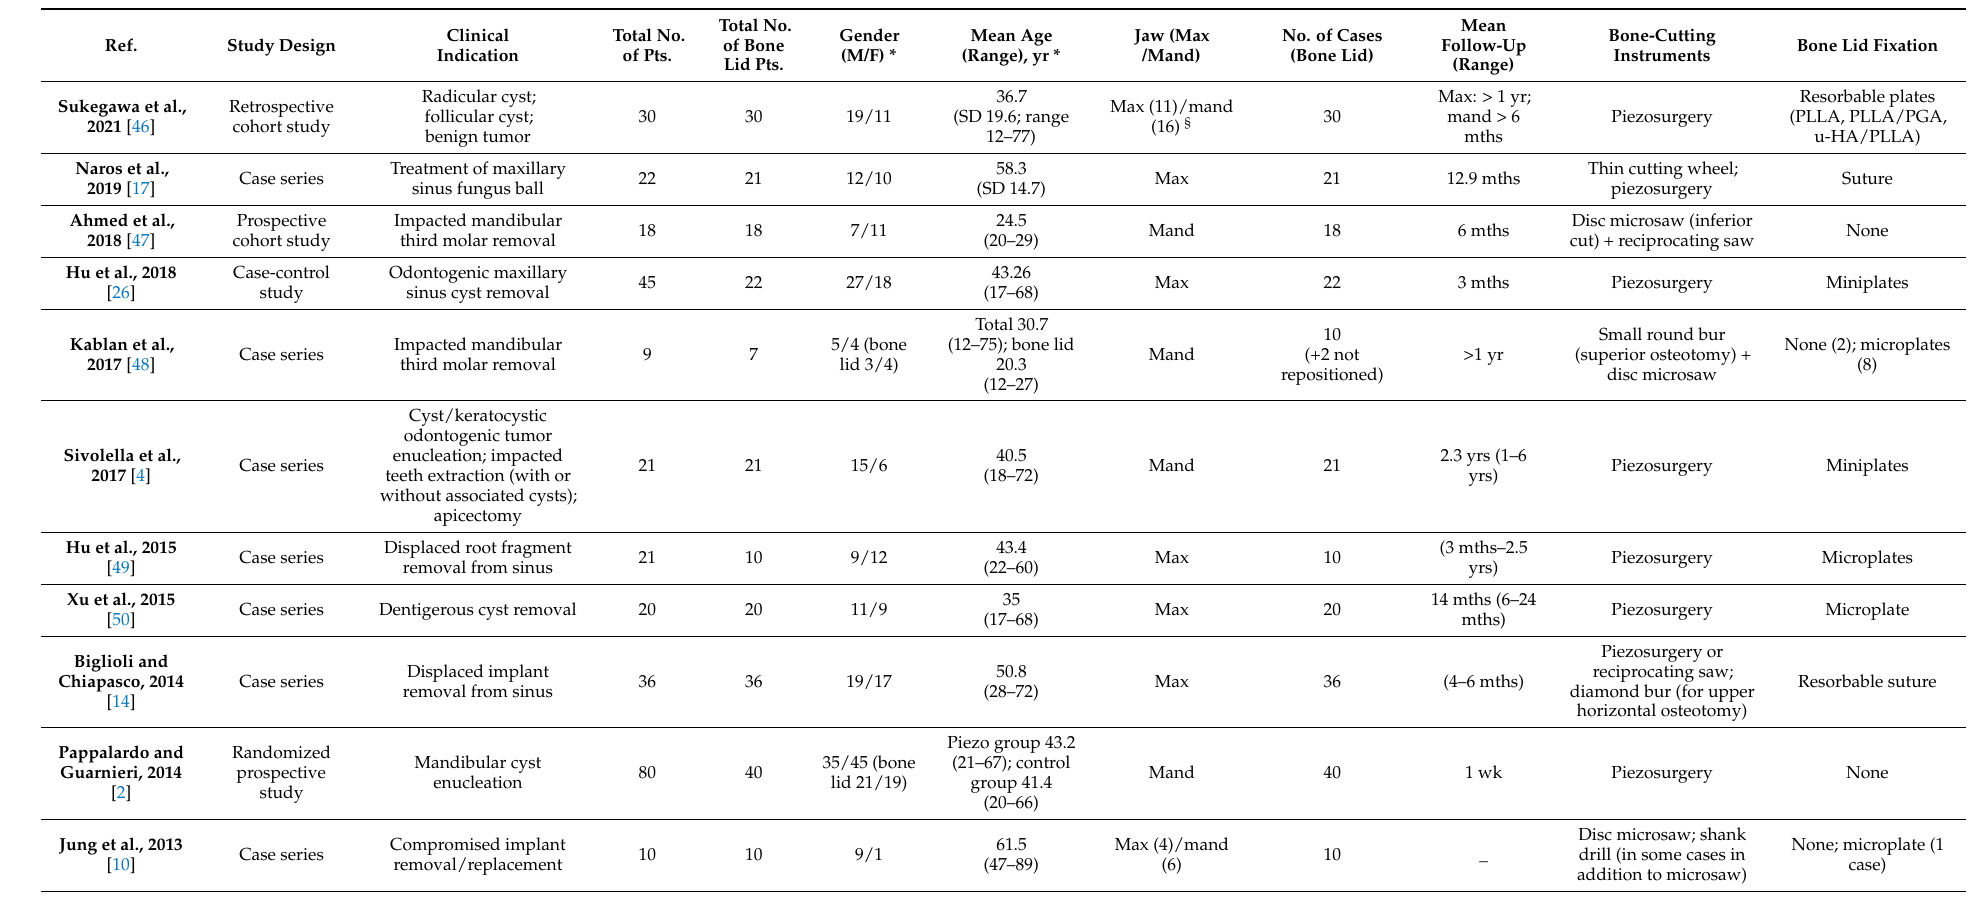
Table 3. Main features of the included